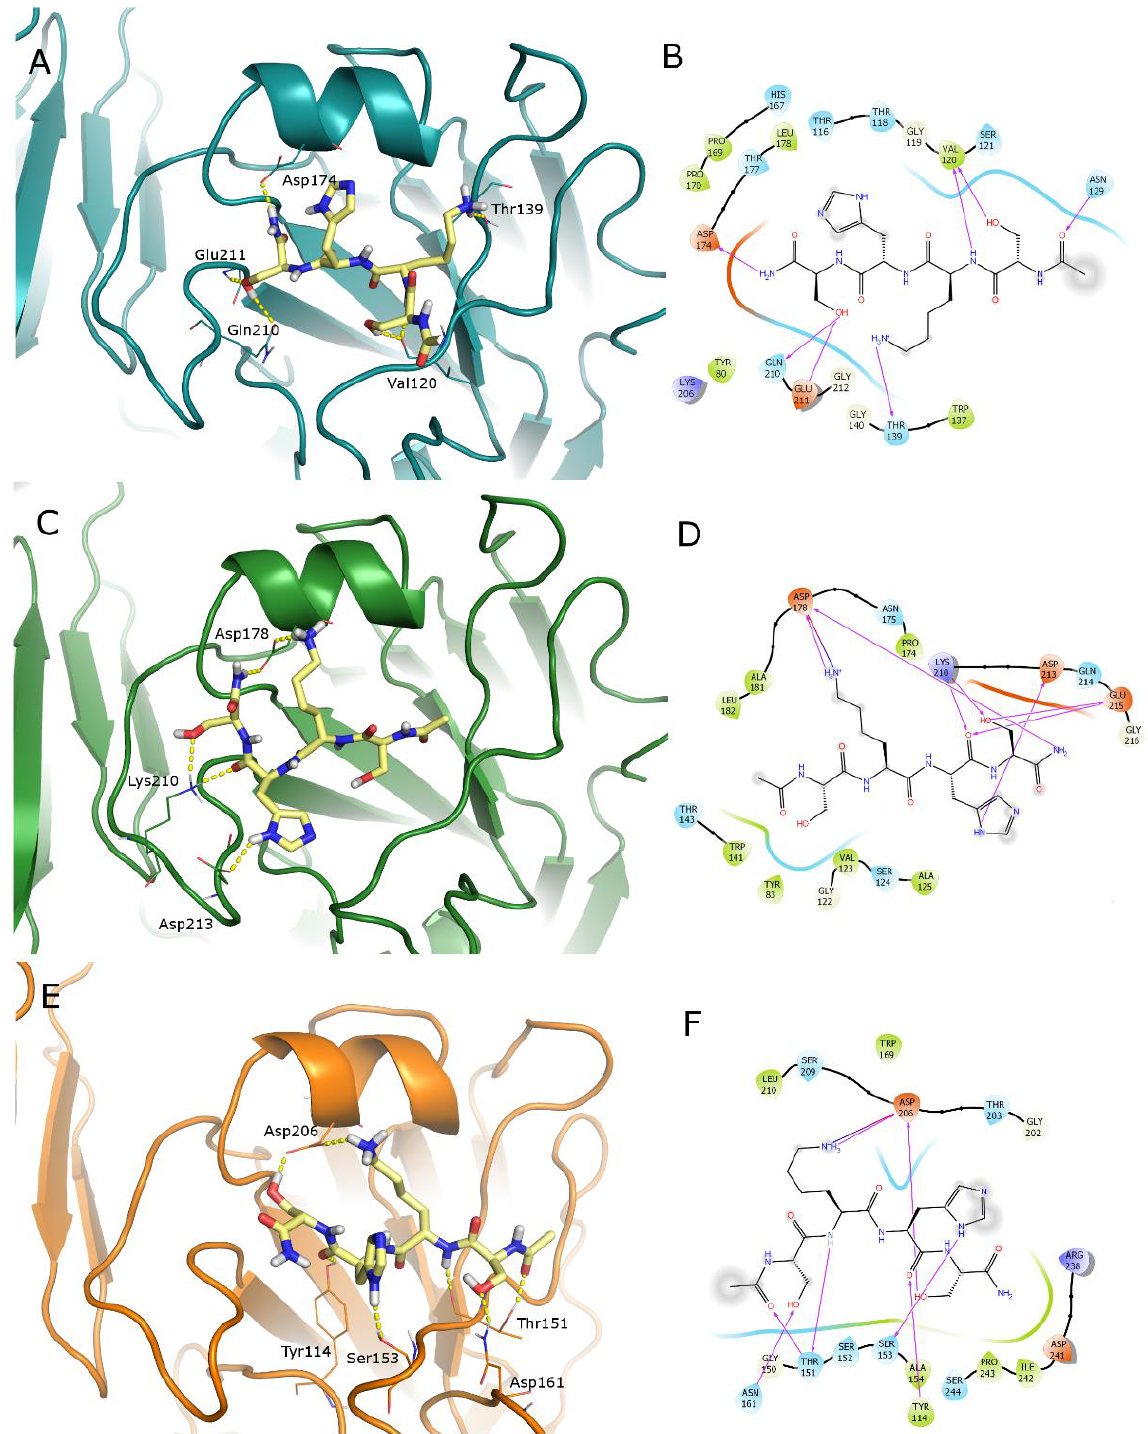
Figure 5. Docked poses of peptide 1 (yellow C atoms, represented as sticks) in the RBS of studied HAs represented as cartoons: ( A ) Parma/H1N1 (deep-cyan); ( C ) Roma/H1N1 (dark green); ( E ) Parma/H3N2 (orange). Residues involved in H-bond interactions with the ligand are represented as lines; H-bonds are depicted as yellow dashed lines. Corresponding 2D ligand interaction diagrams are reported in panels ( B , D , F ); in the diagrams, residues close to the ligand are colored on the basis of their properties (orange, negatively charged; blue, positively charged; green, hydrophobic; cyan, polar), H-bonds are depicted as magenta arrows, solvent-exposed atoms are surrounded by a gray